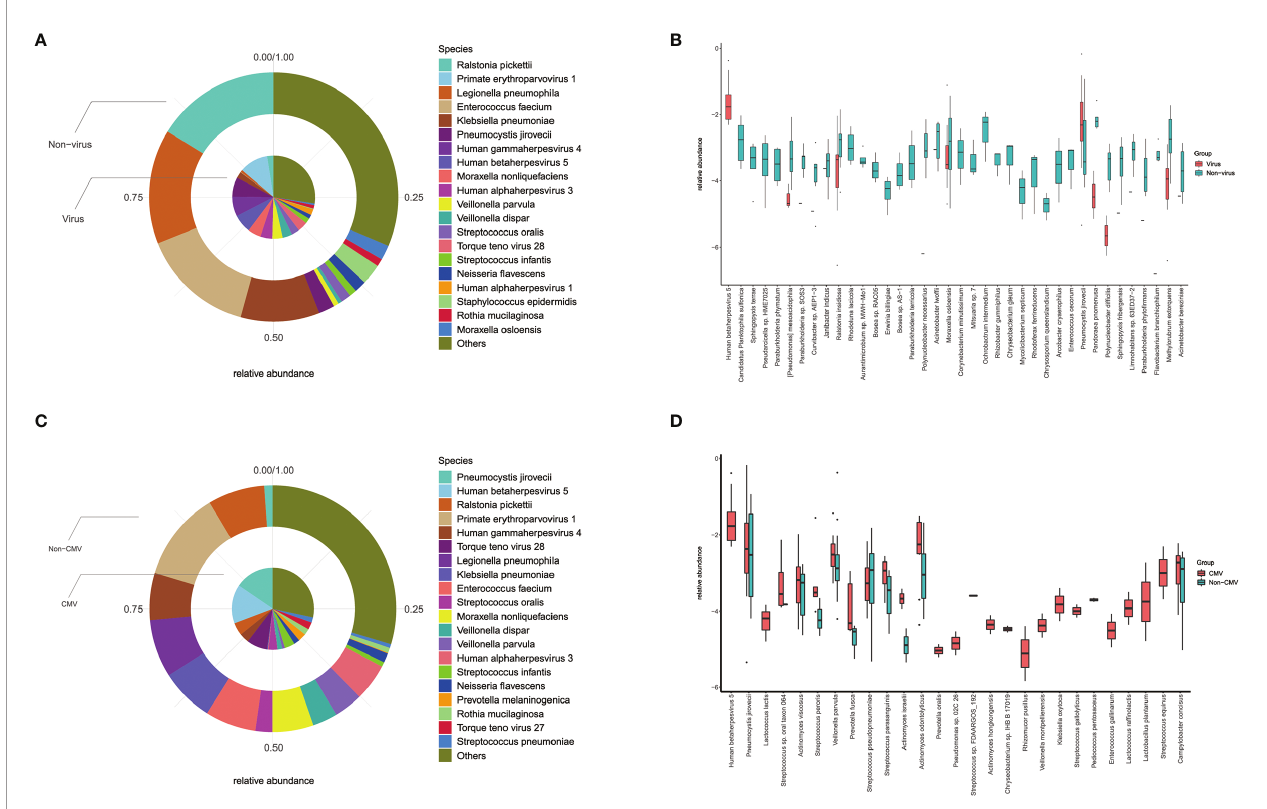
FIGURE 4 | Differences of lung microbiota in groups. (A) Top 20 most abundant species and their relative abundance in virus and non-virus recipients; (B) there were signi fi cant differences in top-20 species (such as Pneumocystis jirovecii, Moraxella osloensis , CMV) and other non-top species between virus and non-virus group; (C) top 20 most abundant species and their relative abundance in CMV and non-CMV infectious recipients; (D) there were signi fi cant differences in top-20 species (such as Pneumocystis jirovecii, Veillonella parvula ) and other non-top species between CMV and non-CMV